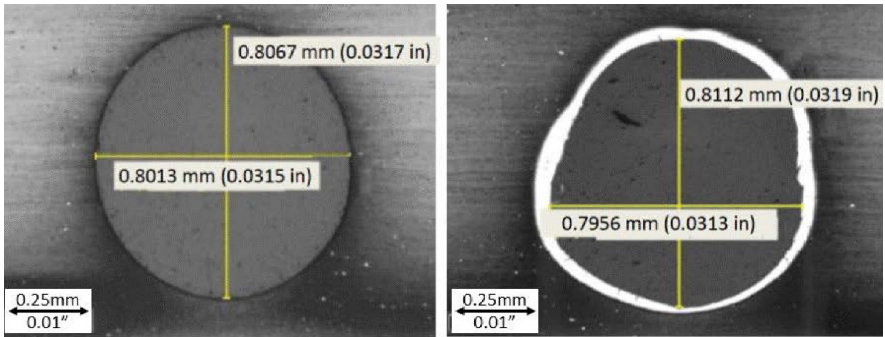
Figure 9. Transverse hole sections (magnification 50x); on the left: sample group—3C (Table 2); on the right: sample group—2C (Table 2).